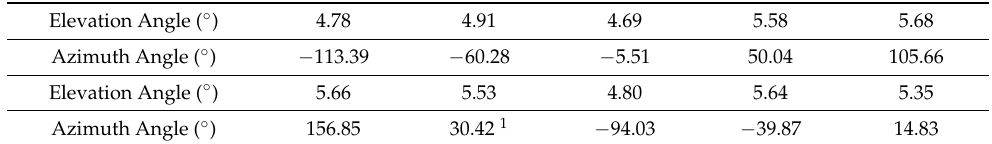
Table 12. DOA estimation of nearby inner race by CPCMA-ESPRIT for rolling element fault signal at 290 rpm.